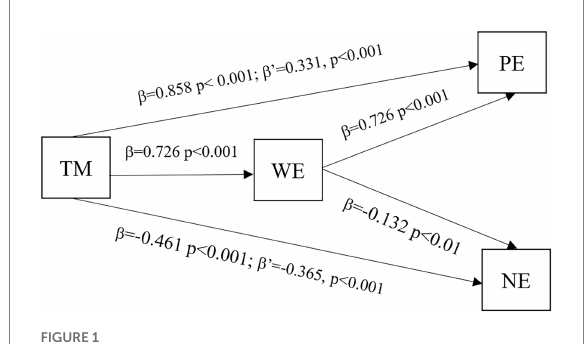
FIGURE 1 The effect of teacher mindfulness on classroom emotions and the mediation of work engagement.